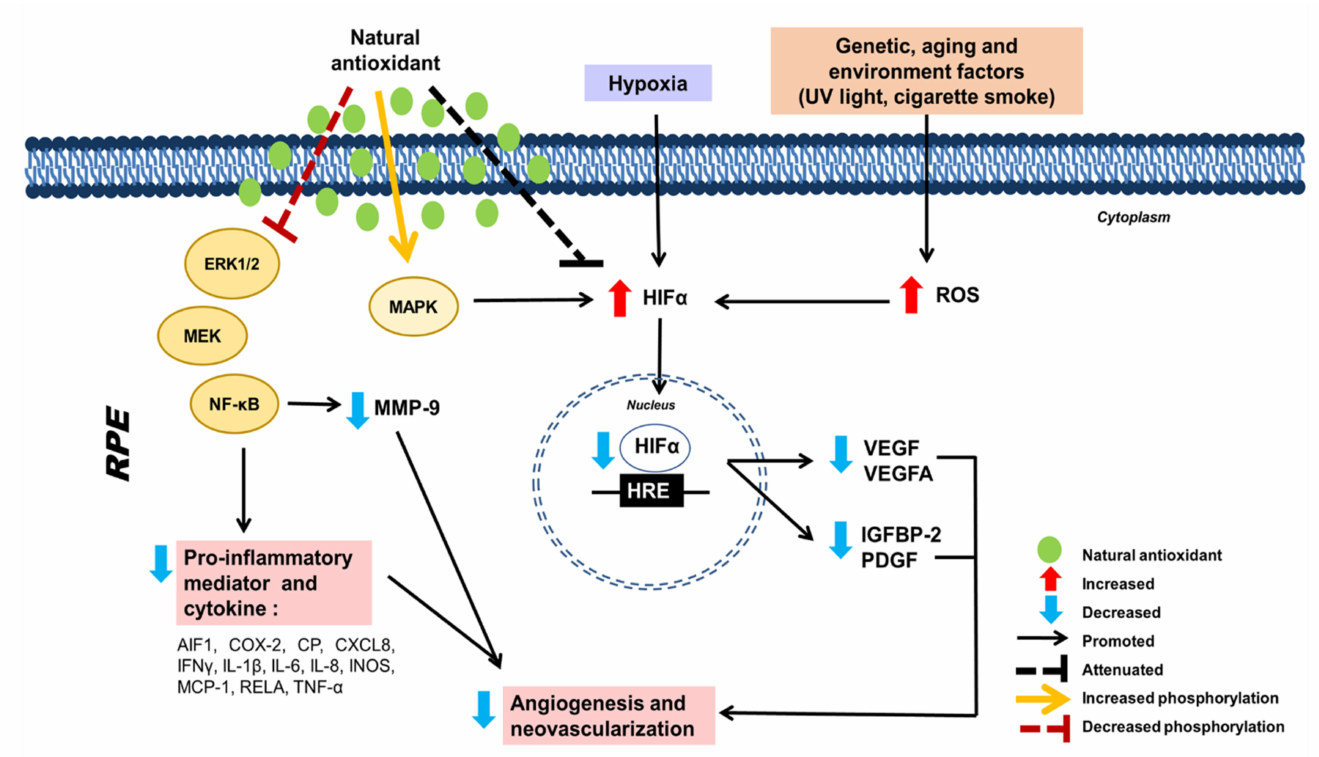
Figure 4. Hypoxia and excessive production of reactive oxygen species (ROS) promote active angio- genesis and neovascularization by upregulating mRNA expression of hypoxia-inducible factor- α (HIF- α ). Modulation of extracellular-signal-regulated kinase (ERK)1/2, mitogen-activated protein kinase kinase (MEK), nuclear factor kappa-light-chain-enhancer of activated B cells (NF- κ B) and p38 mitogen-activated protein kinase (MAPK) activities by natural antioxidants results in decreased inflammation and downregulation of hypoxia response element (HRE). Inhibition of vascular en- dothelial growth factor (VEGF) and platelet-derived growth factor (PDGF) lead to attenuation of angiogenesis and neovascularization. AIF1, allograft inflammatory factor 1; COX-2,